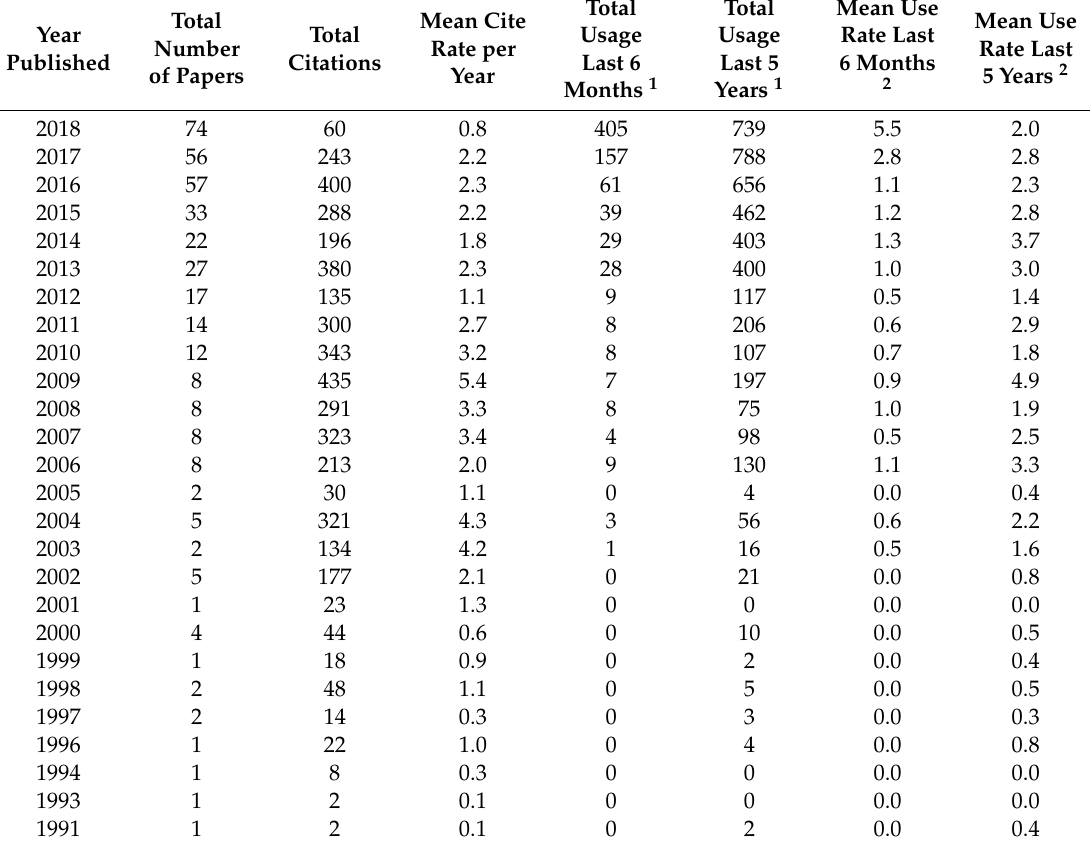
Table 2. General characteristics of